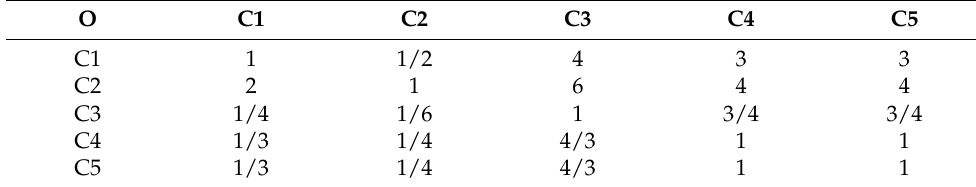
Table 5. Judgment matrix O − C .